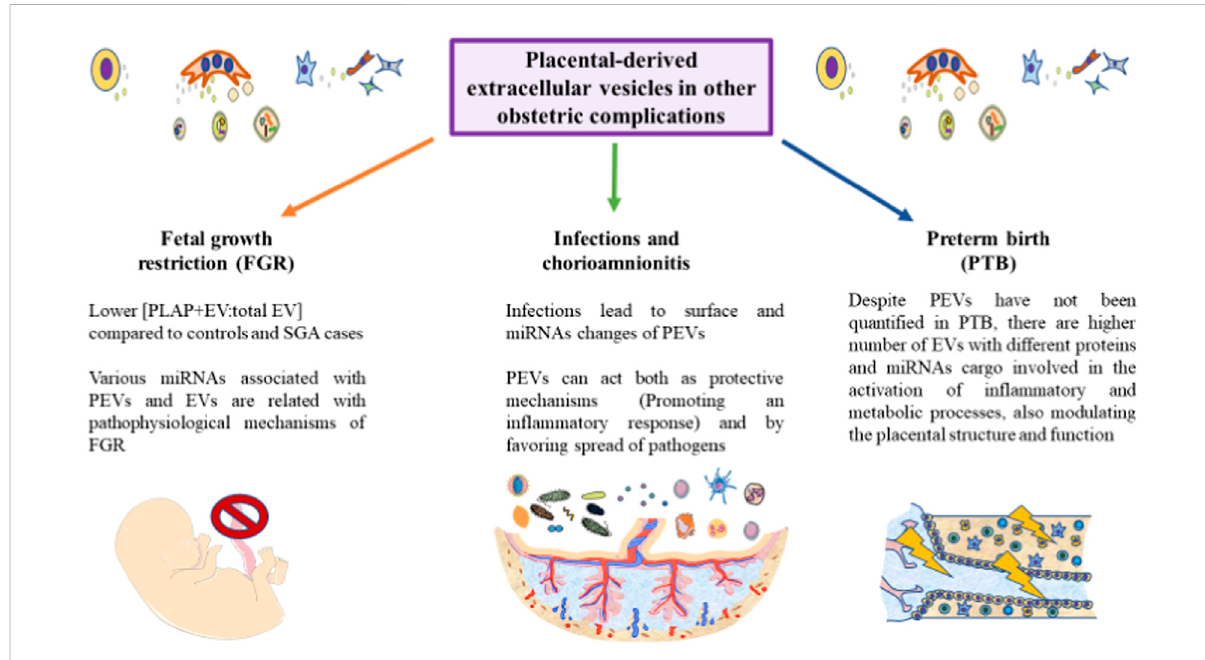
FIGURE 4 A graphical abstract of some of the current notions of PEVs in different obstetric pathologies. As represented, the role of PEVs remains to be further explored in the fi eld of fetal growth restriction, infections and preterm birth. However, some initial results are starting to arise in these conditions, aiding to improve our knowledge of these obstetric complications. Due to the relevance of PEVs in many physiological and pathological processes, we encourage for future studies in these